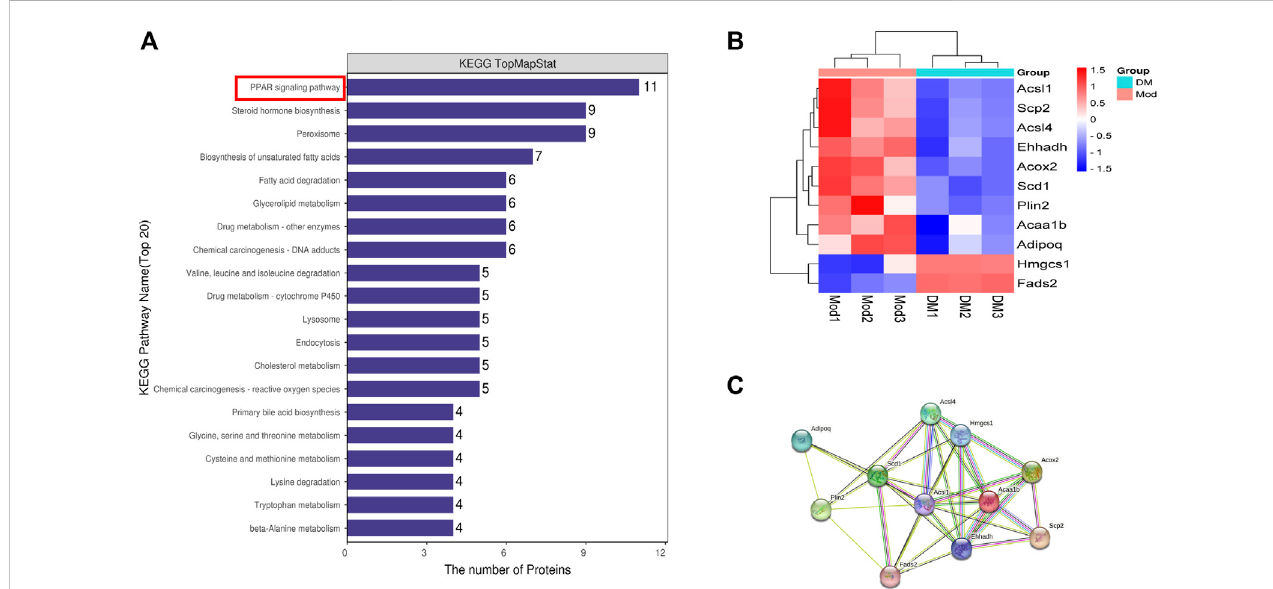
FIGURE 2 (A) The top 20 KEGG pathways enriched in DSEPs. (B) Heat map of differentially expressed genes in peroxisome proliferators-activated receptor (PPAR) signalingpathway. (C) Searchtoolforrecurringinstancesofneighboringgenes(STRING)networkvisualizationofthegenesindifferentiallyexpressedgenesin the PPAR signaling pathway. Edges represent protein-protein